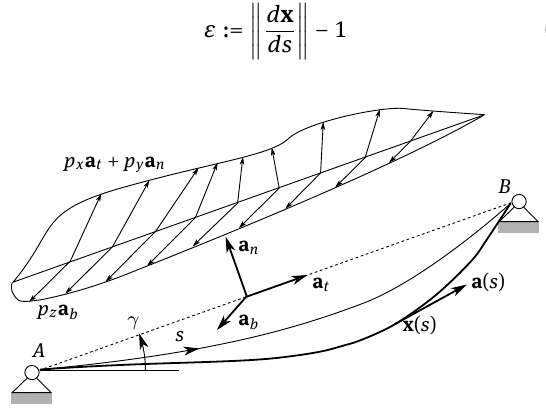
Figure 1: Shallow cable under general 3D-forces, referred to a basis intrinsic to the chord. Dashed line: chord; thin line: cable with no loads; thick line: equilibrium position of the cable with